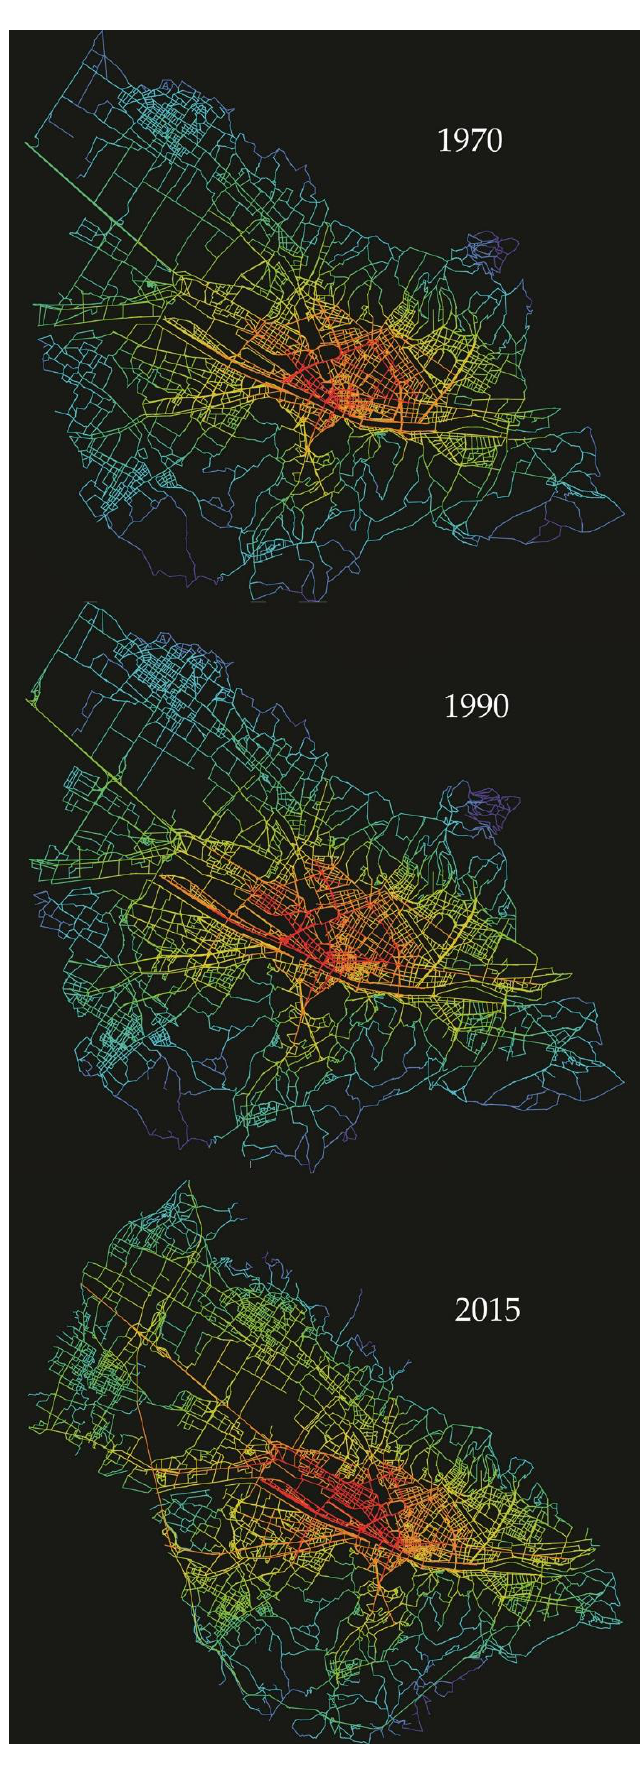
Figure 5. Distribution of global integration in Florence, 1970–2015.